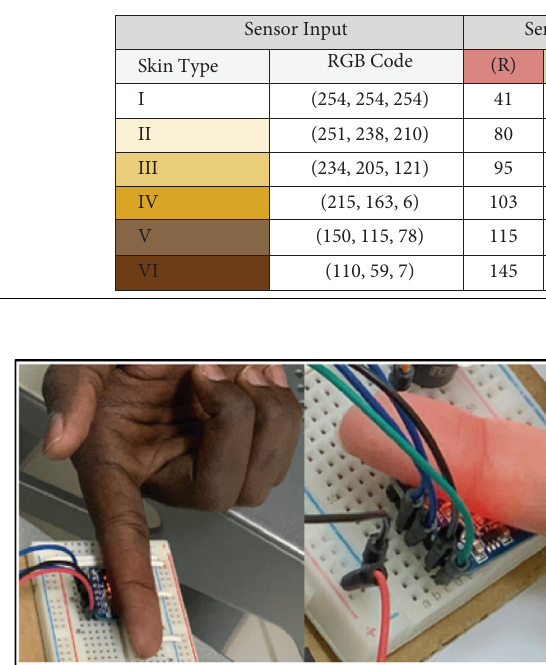
Table 3: Te diference between the exact RGB codes of skin color and the sensor reading for similar colors.